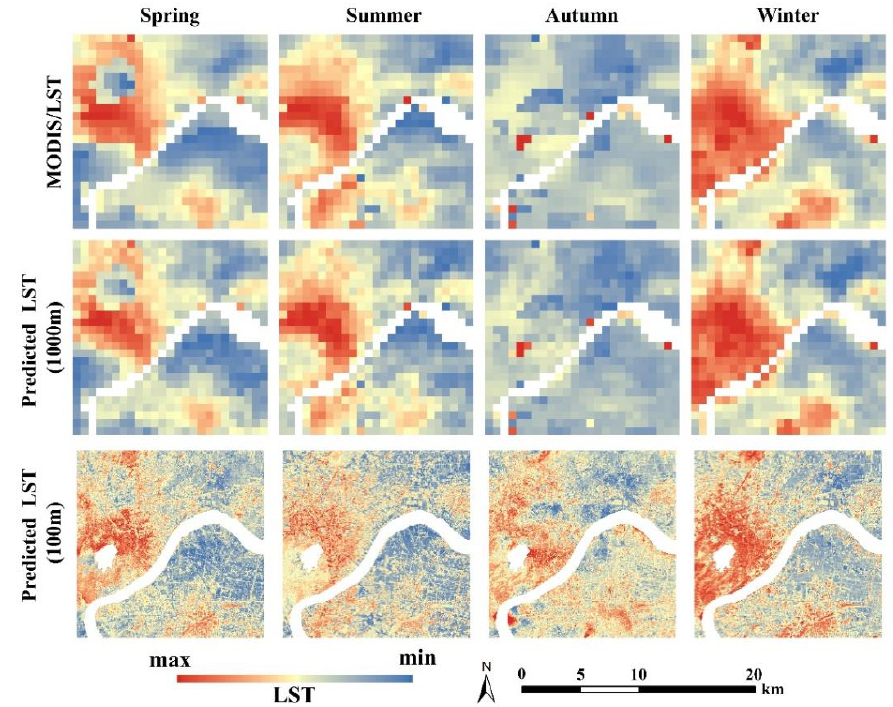
Figure 15. Predicted and downscaling results at night at different scale in various seasons from MODIS/LST products.